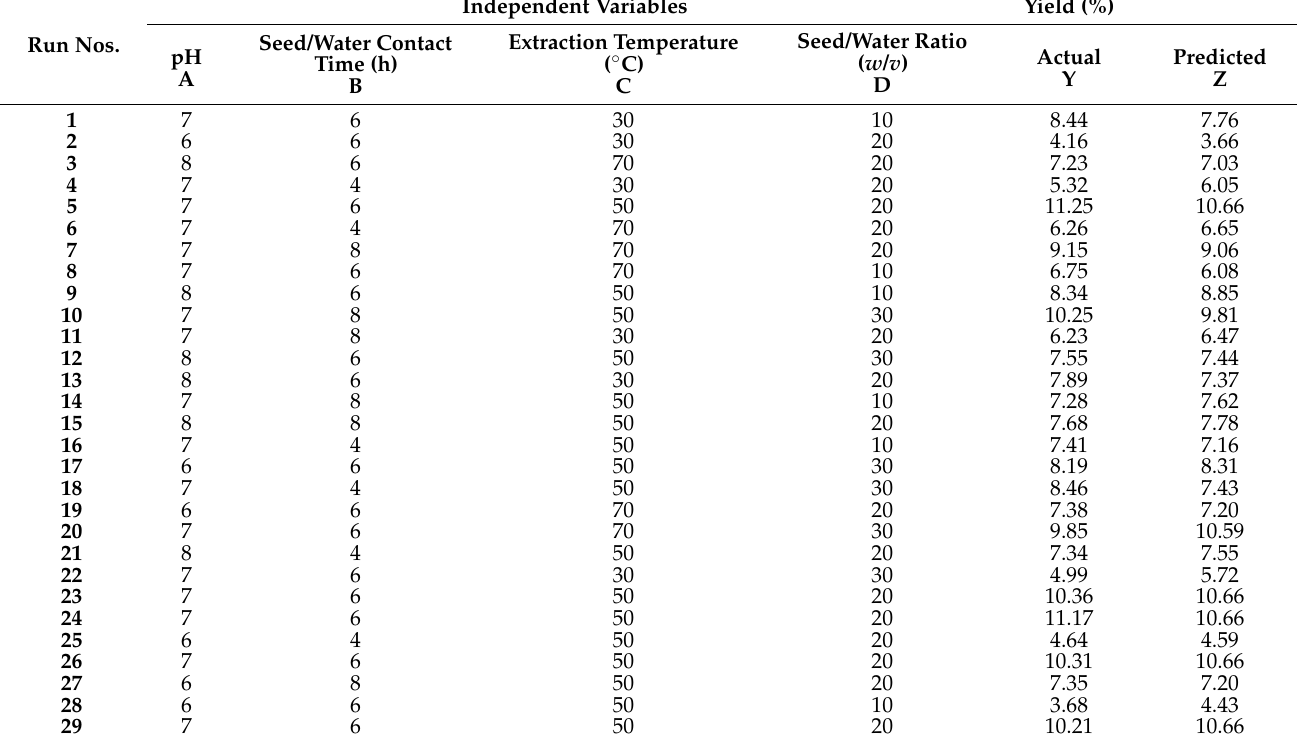
Table 2. RSM-BBD experimental design and actual vs. predicted yield of MPM